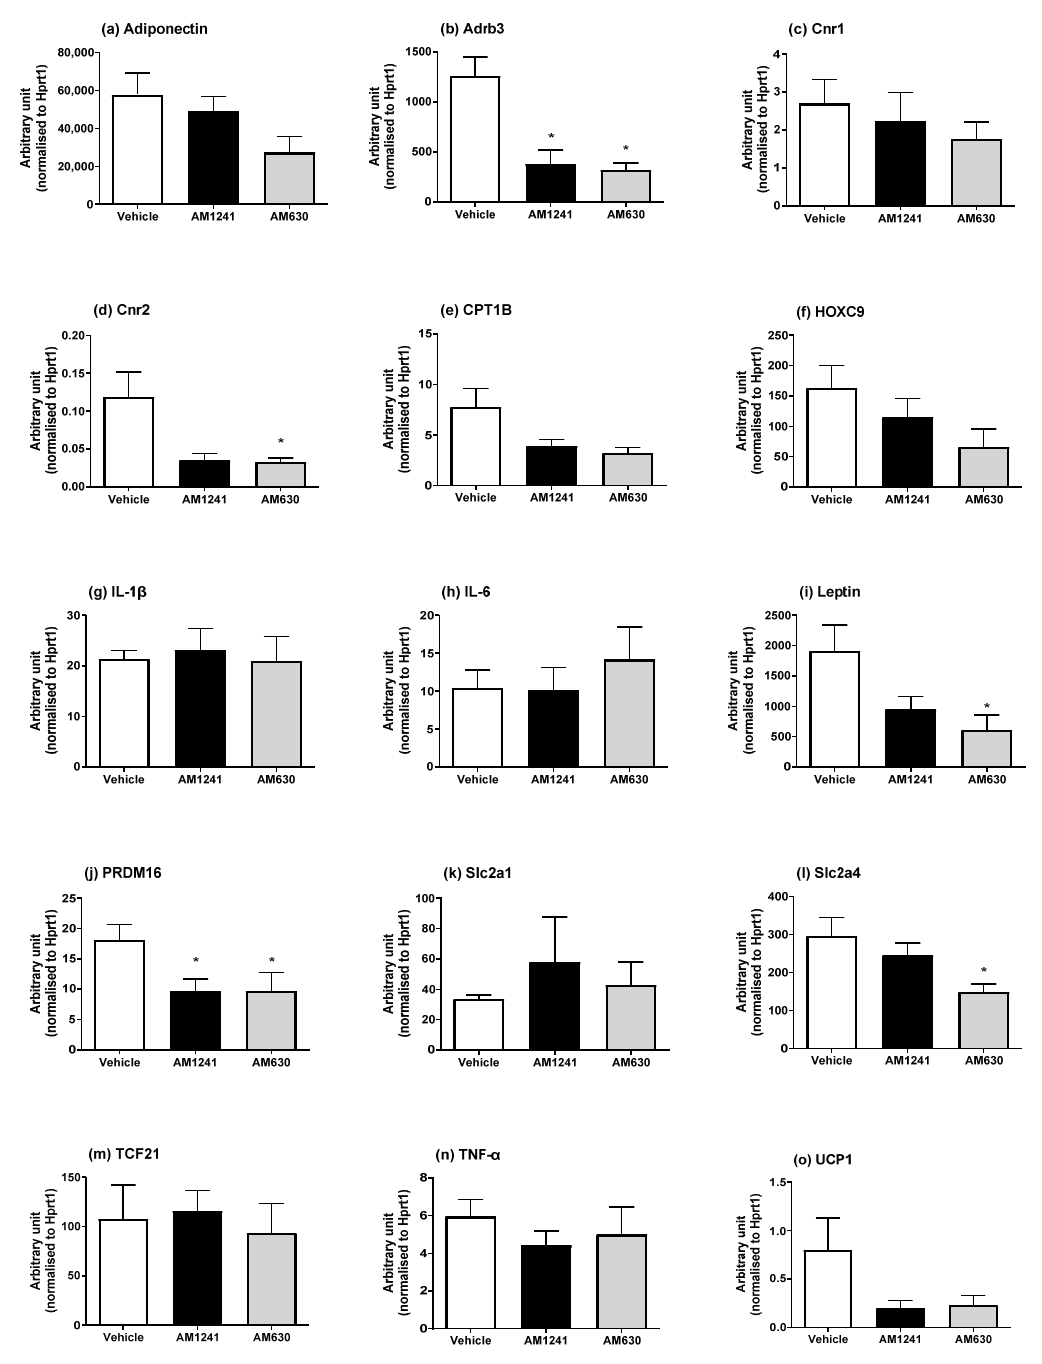
Figure 2. Effect of AM1241 or AM630 treatment on DIO rats’ epididymal WAT mRNA expression. DIO rats were injected daily with AM1241 (3 mg/kg of body weight, ip), AM630 (0.3 mg/kg of body weight, ip), or vehicle for six weeks. All results are presented as a mean ± SEM in arbitrary units (normalized to housekeeping gene HPRT1 ) from n = 6–7 (AM1241)-, n = 6–9 (AM630)-, and n = 7–9 (vehicle)-treated DIO rats. Significance * p < 0.05 compared to vehicle.